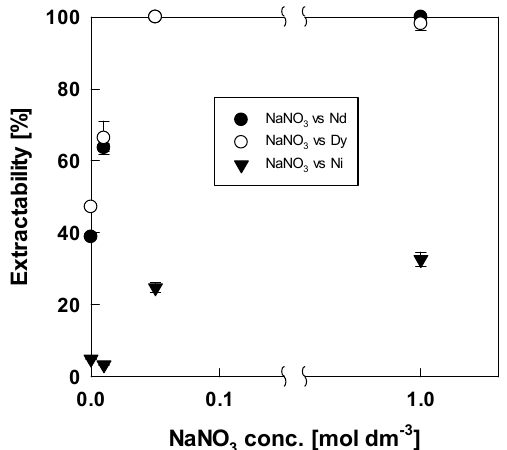
Figure 3. Effect of NaCl concentration on metal extractability. Figure 3. E ff ect of NaCl concentration on metal extractability.